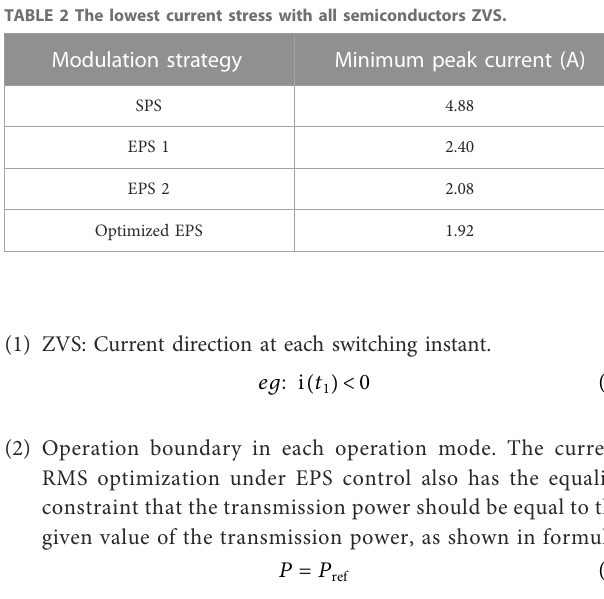
Figure 5 is a control block diagram of the DAB converter under the control of the EPS. And calculating the voltage matching ratio according to V 1 and V 2, performing constraint optimization calculation on the calculated duty ratio, and obtaining the duty ratios D 1 and D 2 according to k . Then according to the EPS modulation method proposed in this paper, the trigger signals of all IGBTs are obtained to make DAB operate normally.